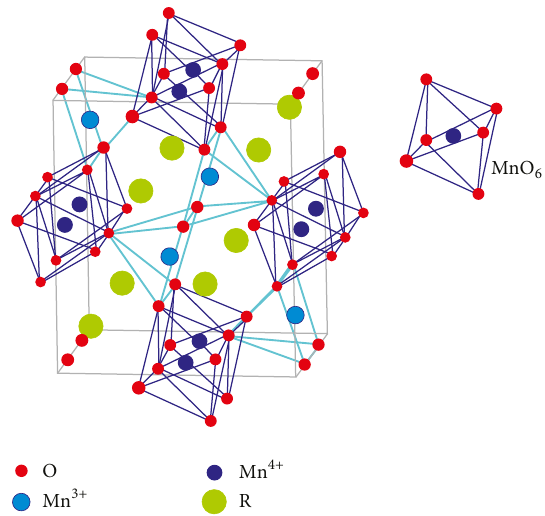
Figure 1: Crystal structure of 𝑅 Mn 2 O 5 .